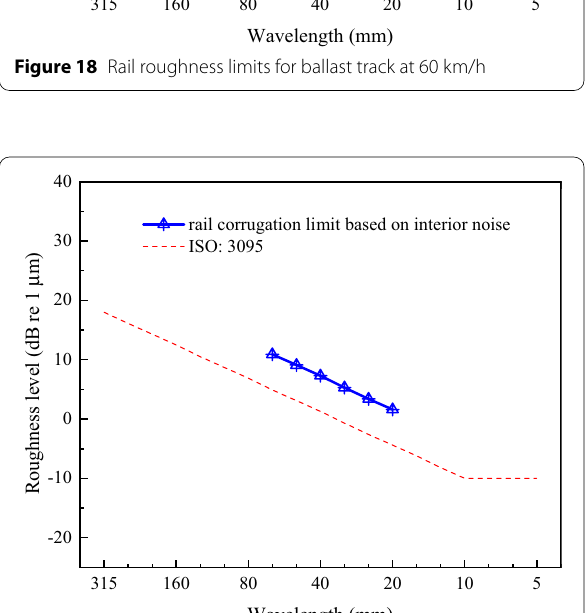
Figure 19 Rail corrugation acceptance criteria on